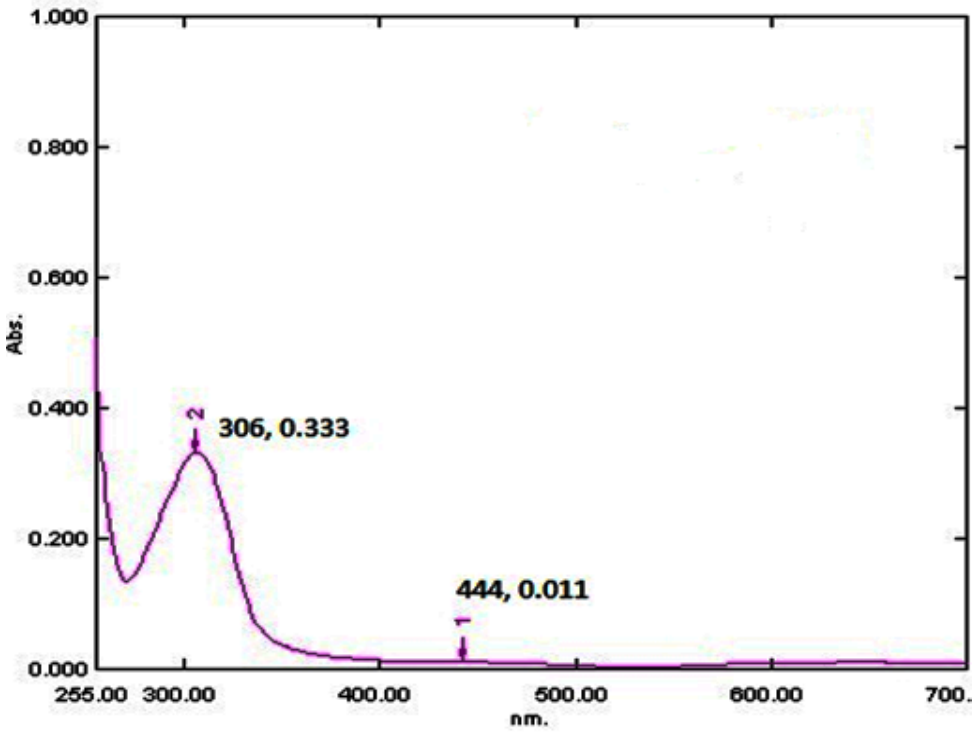
Figure S13: UV/Visible spectrum of diketone monomer o -HOA